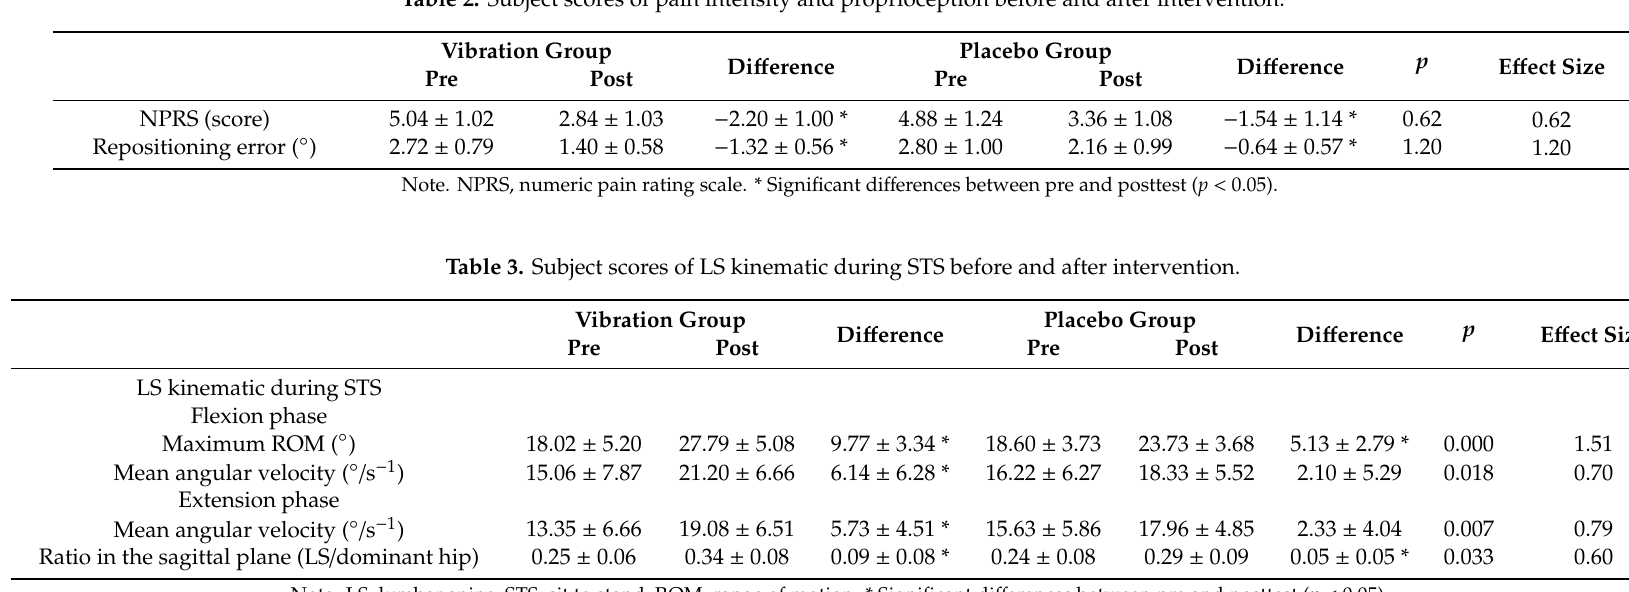
Table 2. Subject scores of pain intensity and proprioception before and after intervention.